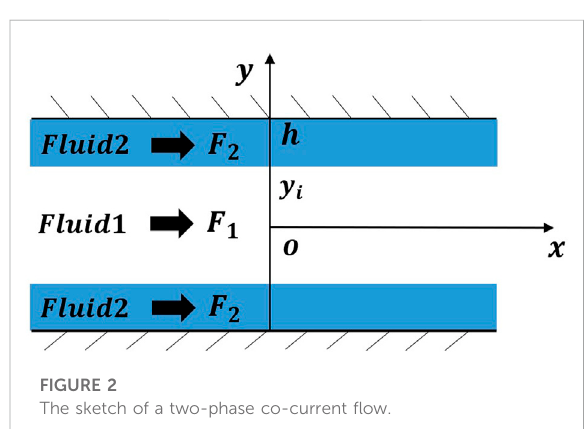
FIGURE 2 The sketch of a two-phase co-current fl ow.